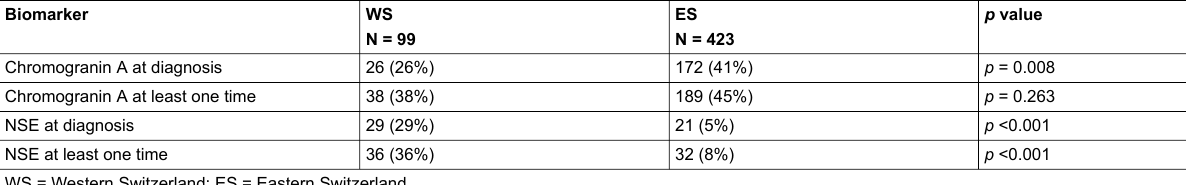
Table 4: Outcome of 348 patients followed for a median time of 318 days. All regions N =